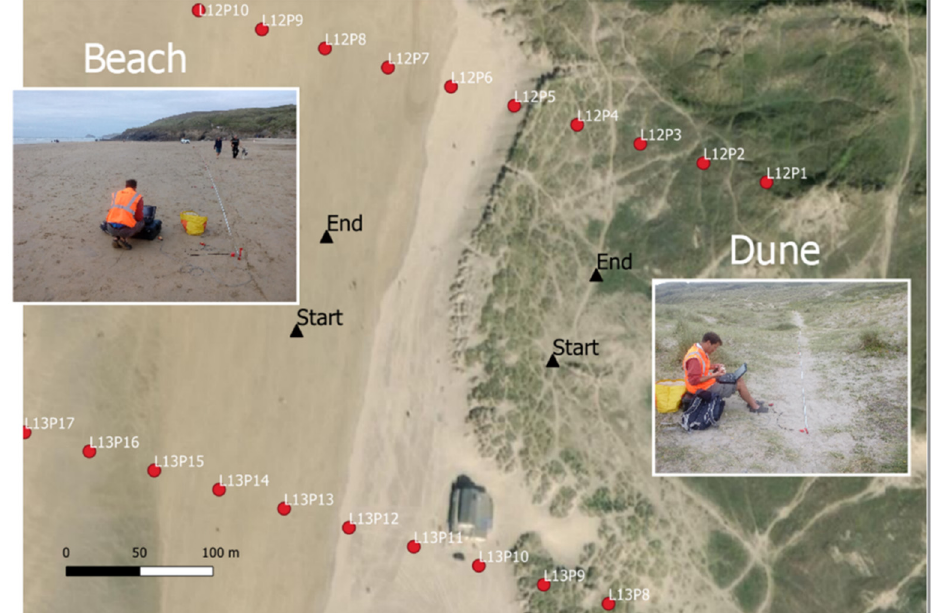
Figure 5. Location of the MAWS set up on the beach and dune. Pictures labelled as beach and dune show the field survey setup at Perran Beach on 23 August 2017 (source BGS). The location of the first and ninth geophones are indicated by the black triangles and labelled as start and end, respectively. Source of aerial imagery is the ArcGIS World Imagery accessed on 13 August 2020: Esri, Maxar, GeoEye, Earthstar Geographics, CNES/Airbus DS, USDA, USGS, AeroGRID, IGN, and the GIS User Community.